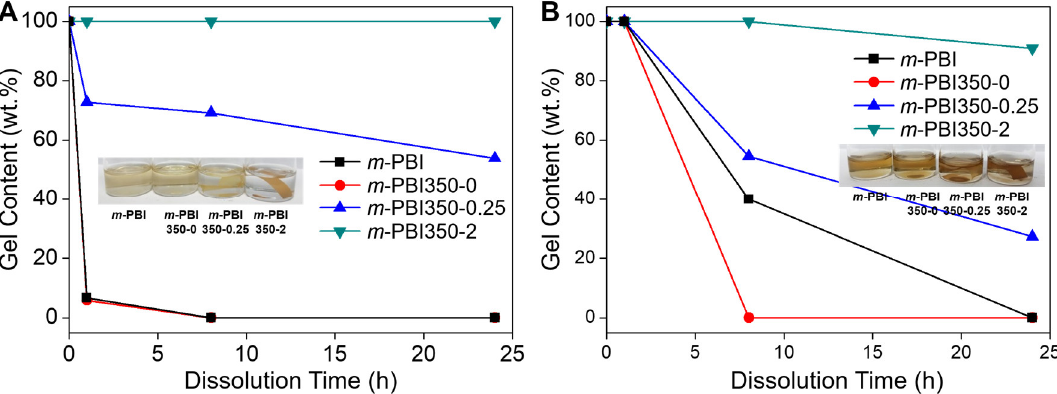
Figure 3. ( A ) n -Butanol adsorption porosity (%) values of m -PBI350-x membranes with respect to duration of heating time at 350 °C (inset: digital camera photographs of m -PBI350-x membranes). Scanning electron microscopy images of the cross-section of ( B ) m -PBI350-0 and ( C ) m -PBI350-3; and the membrane surface of ( D ) m -PBI350-3 glass side and ( E ) air side. ( F ) Cross-section of m -PBI350-0.25 and ( G ) image of the membrane after acid removal.